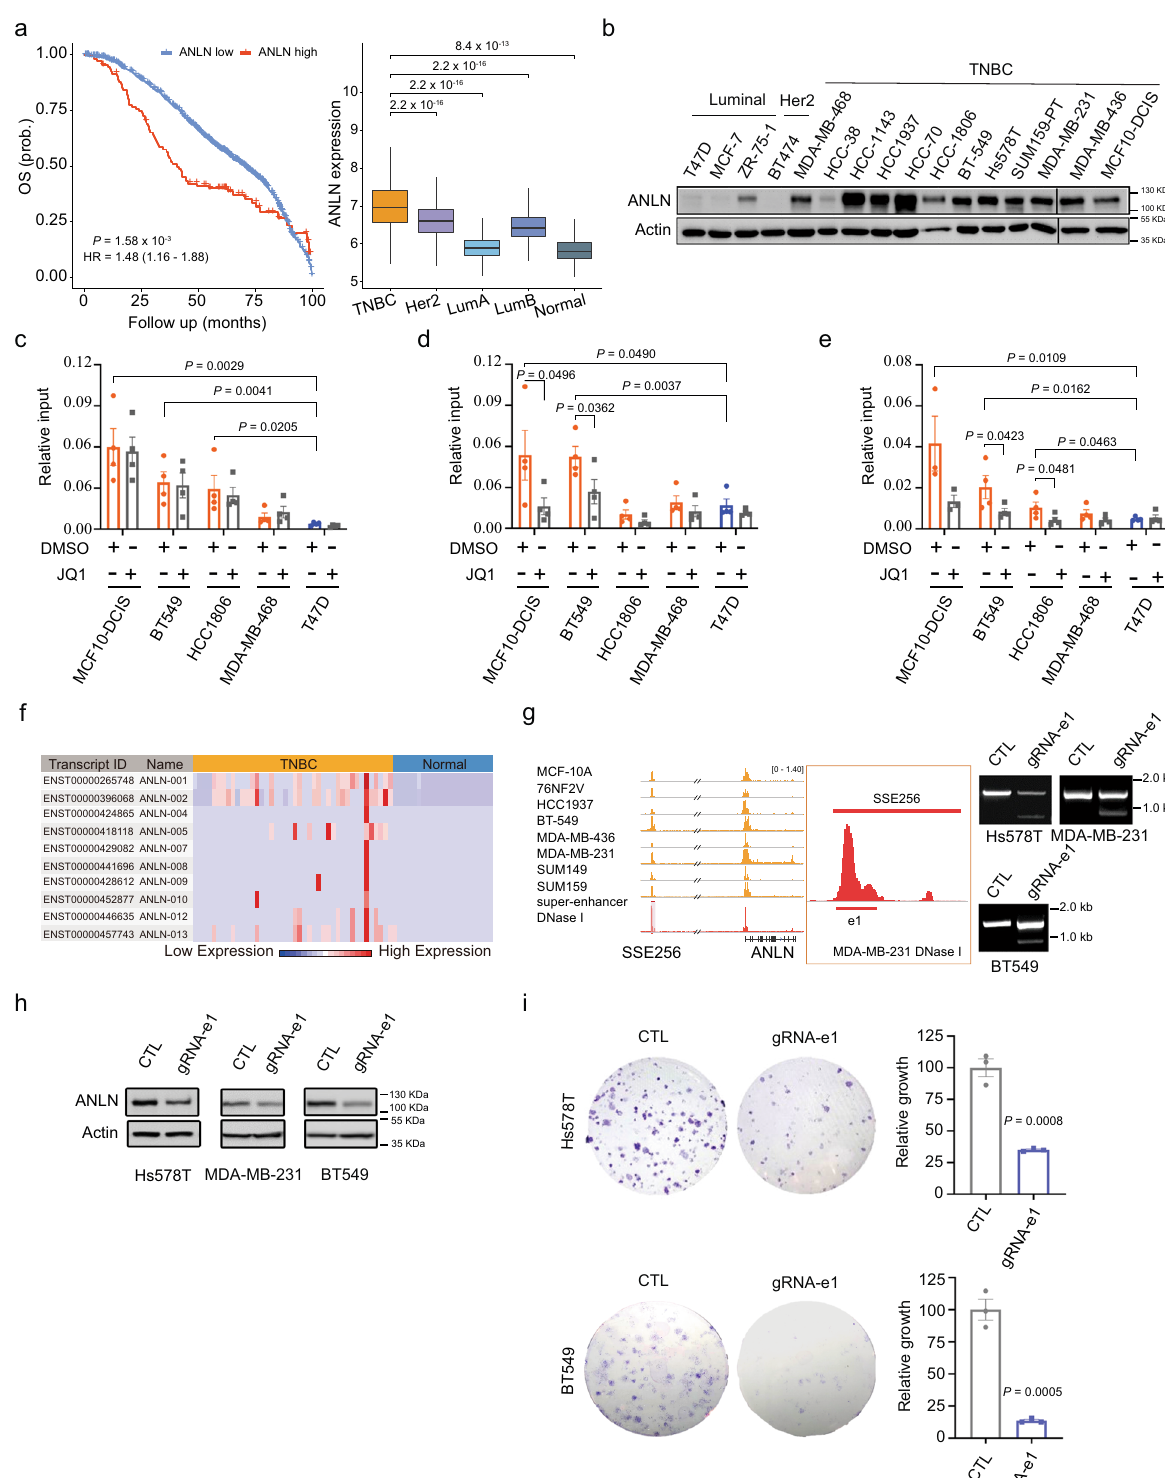
Subtype-speci fi c super-enhancer identi fi cation . For each cell line, we fi rst cal- culated the density of normalized mapped reads in SEs by Bamliquidator (version 1.3.8, https://github.com/BradnerLab/pipeline/wiki/bamliquidator) 16 . In brief, ChIP-seq reads of H3K27ac located within identi fi ed SEs with extended fl anking regions (200bp upstream and downstream) were used to calculate the density of reads per base pair, which was subsequently normalized by the total number of million mapped reads. The resulting read density in units of reads per million mapped reads per bp (rpm/bp) was de fi ned as H3K27ac enrichment signals of